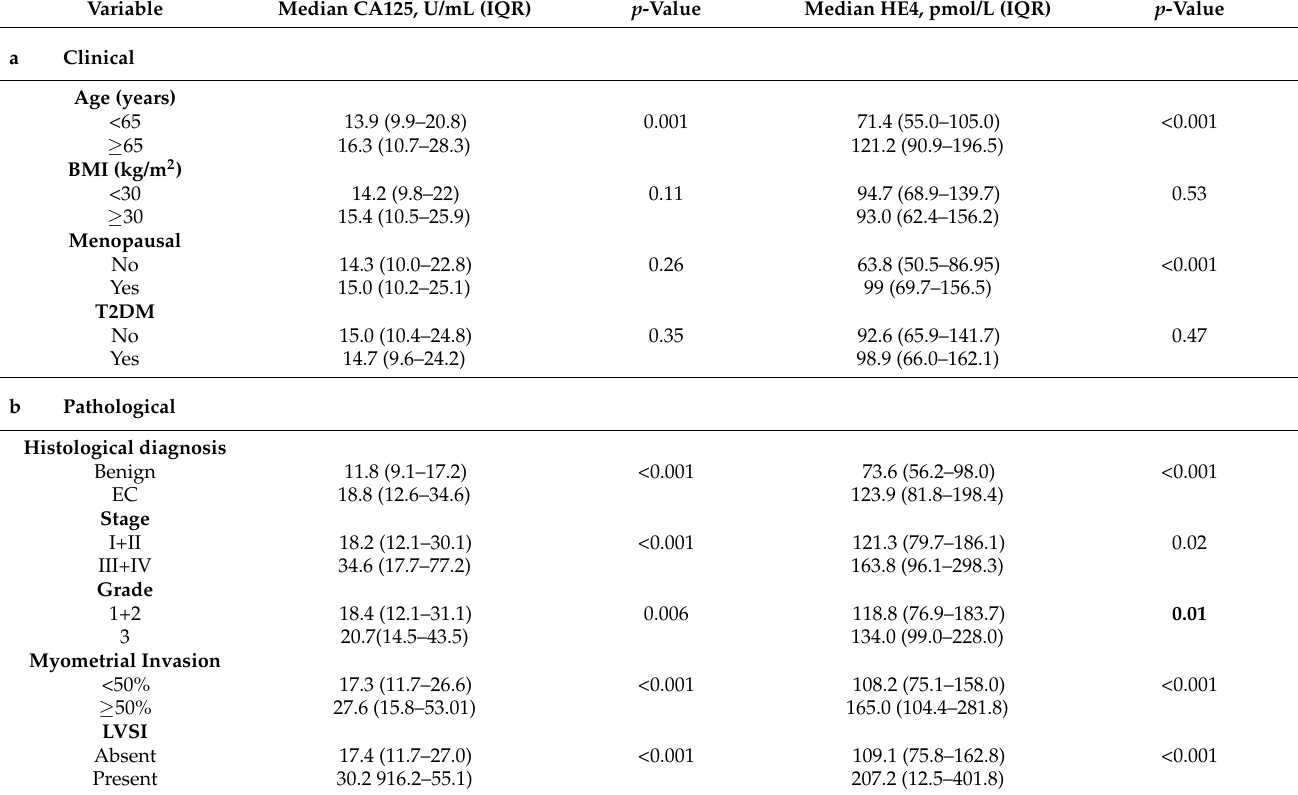
Table 4. Summary of serum CA125 and HE4 and clinico-pathological